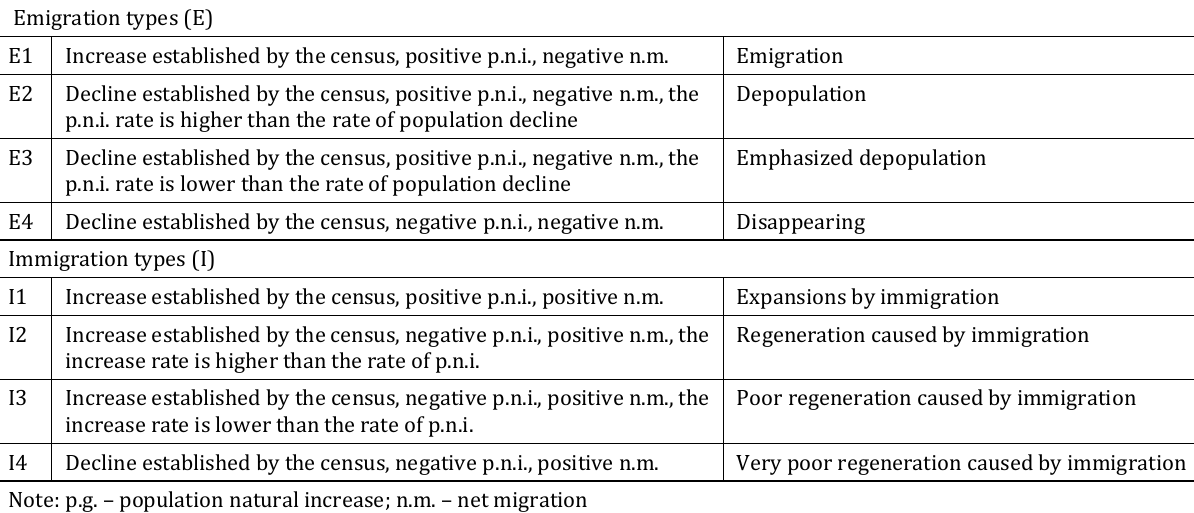
Table 2. Types of general population movements based on population natural increase and net migration by Friganović, according to a modified Clark model (source: Vojković,